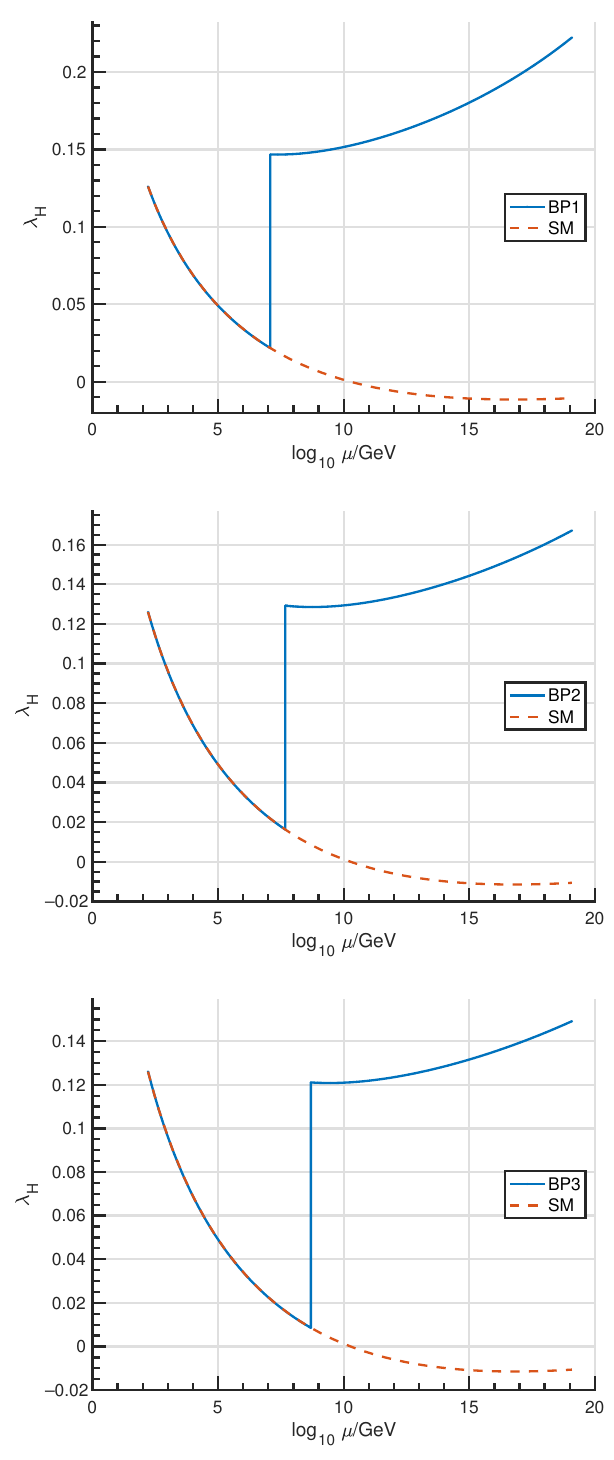
Figure 5. Running of SM Higgs quartic coupling in Standard Model (dashed line) and in SMASH with benchmark points BP1 – BP3 (solid line). Threshold correction is utilized at m ρ